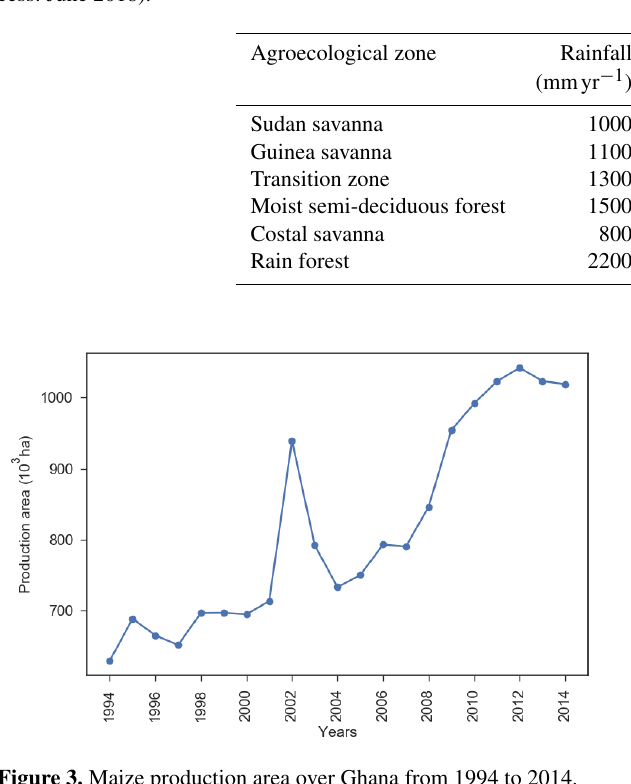
Figure 2. Agroecological zones of Ghana (source: Sidibe et al., 2016) and average seasonal rainfall pattern of each agroecological zone based on TAMSAT rainfall estimates. Table 1. Characteristics of agroecological zones in Ghana (source: http://www.fao.org/nr/water/aquastat/countries_regions/GHA/, last ac- cess: June 2018).